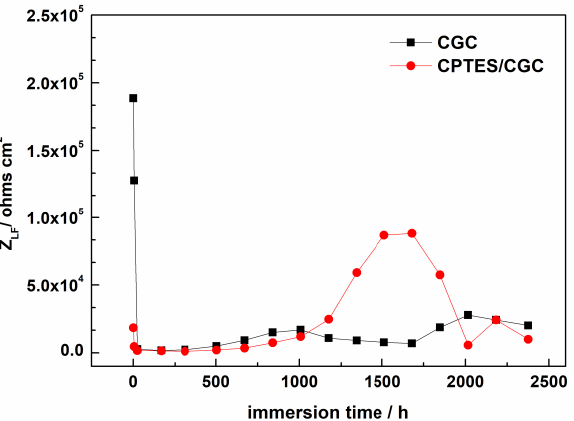
Figure 7. The evolutions of the low frequency impedance modulus Z LF with immersion time for coatings.